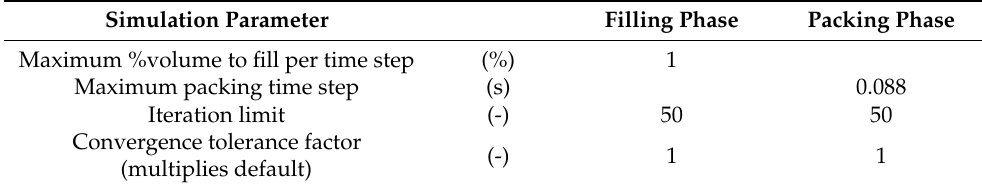
Table 4. Convergence criteria for filling and packing phase.